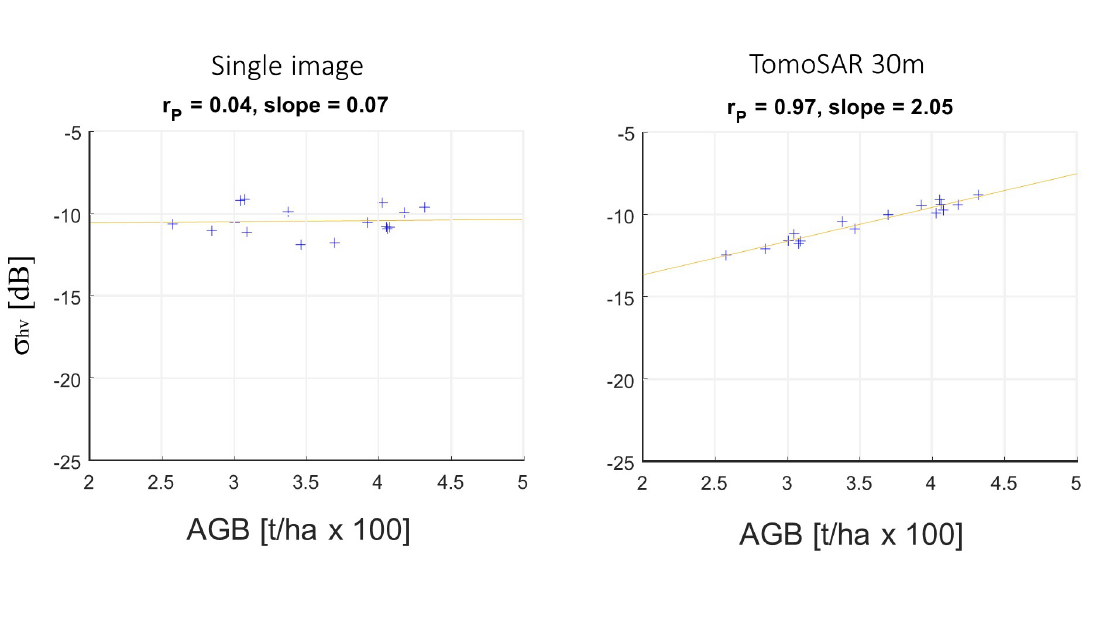
Figure 2. Correlation between HV synthetic aperture radar (SAR) intensity and above-ground biomass (AGB) from ground plots at Paracou [22,23]. Backscatter is expressed as sigma naught, accounting for local topography [12]. Left: 2D SAR. Right: tomographic intensity at 30 m above the ground. The correlation coefficient r p and slope are also